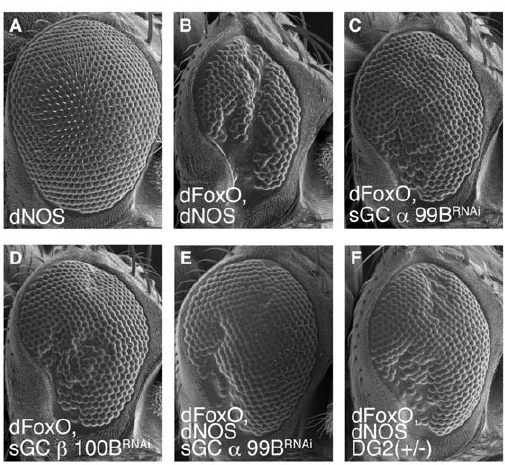
Figure 8. NO signal is involved in FoxO-mediated neurode- generation. ( A–D ) SEM images of the eyes of flies expressing the indicated genes. The genotypes are: GMR-Gal4/UAS-dNOS ( A ), GMR- Gal4, UAS-dFoxO/UAS-dNOS ( B ), GMR-Gal4, UAS-dFoxO; UAS-sGC a 99B RNAi ( C ), GMR-Gal4, UAS-dFoxO; UAS-sGC b 100B RNAi ( D ), GMR-Gal4, UAS- dFoxO/UAS-dNOS; UAS-sGC a 99B RNAi ( E ), GMR-Gal4, UAS-dFoxO/UAS- dNOS, DG2 k04703 ( F ).